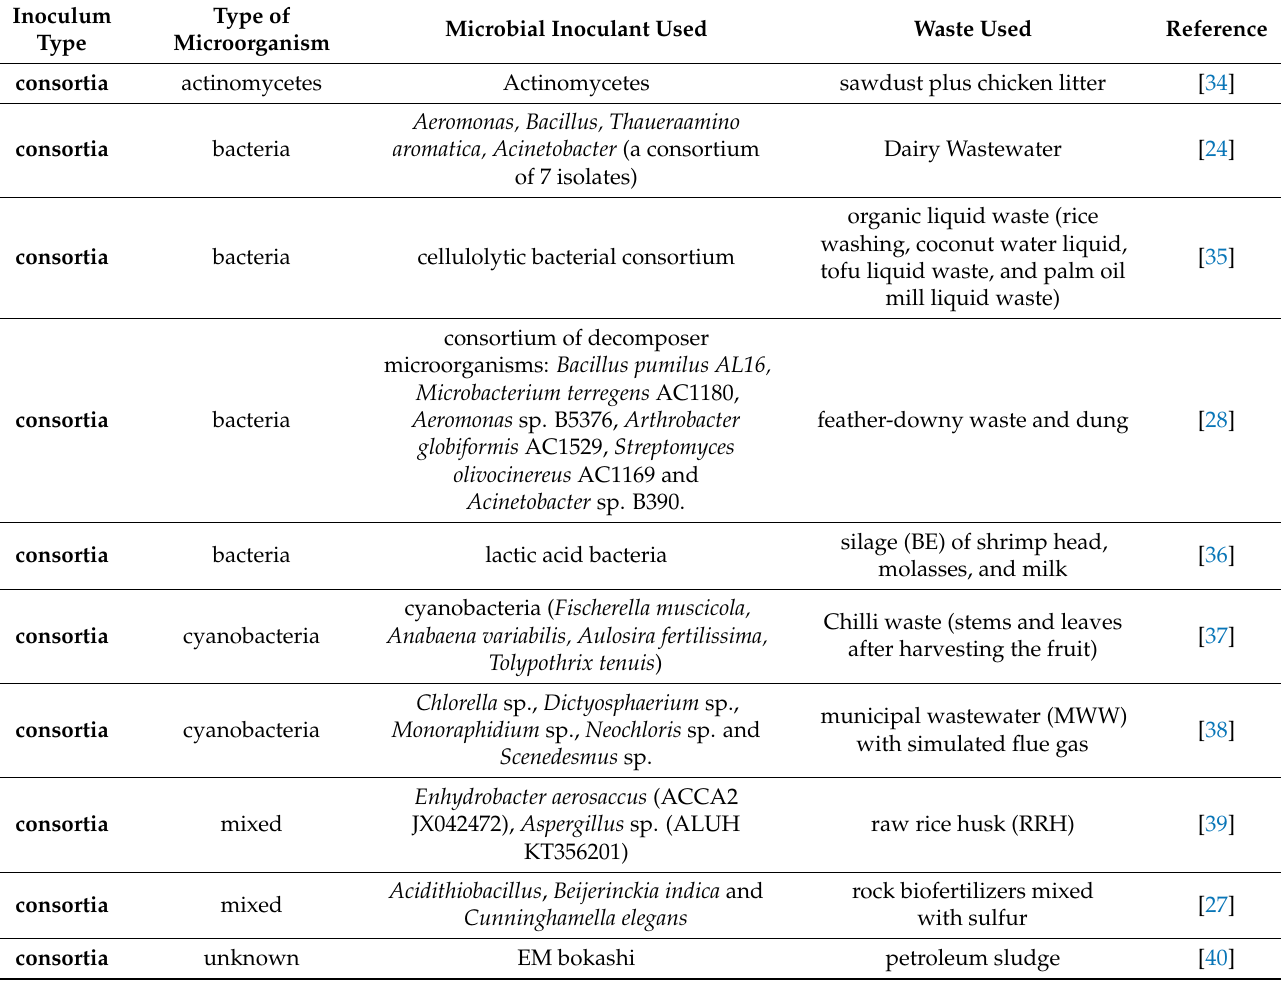
Table 5. Different types of consortia used for bioconversion of